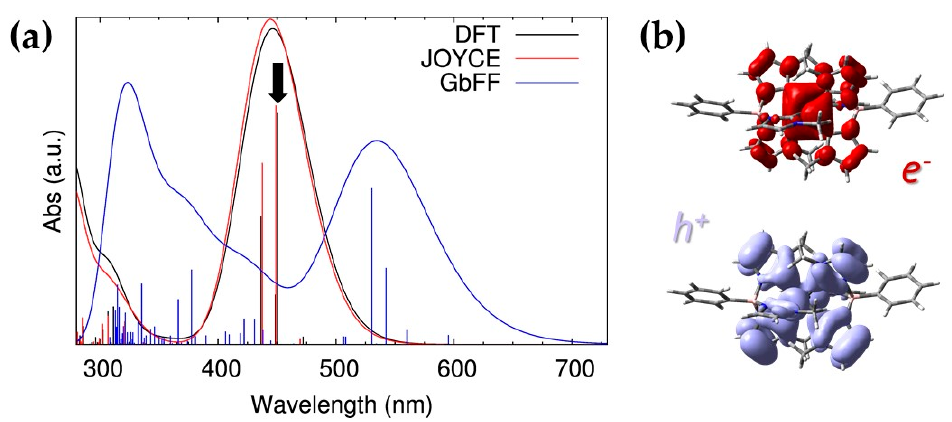
Figure 6. Absorption properties for the zero temperature structures: ( a ) Simulated spectra for the complex geometries obtained upon DFT (black), MM based J oyce (red) and GbFF (blue) energy relaxations. ( b ) NTOs of the main transition involved in the ( 2 LMCT) band of the DFT optimized spectrum as highlighted by the black arrow on the left graph. Purple / magenta colors are used to visualize the holes / electrons isosurfaces, which were plotted with an isovalue equal to 0.02 a.u. All vertical excitations have been computed at the TD-B3LYP* / 6-311G* level of theory.